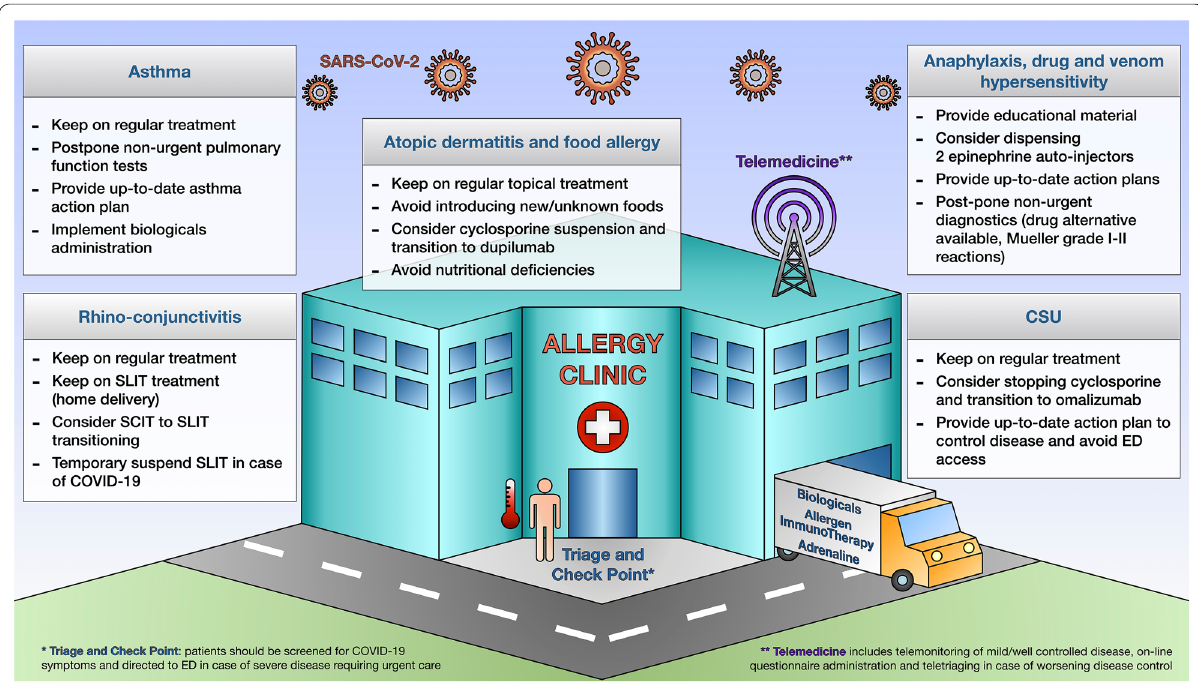
Fig. 2 An integrated model of tele- and digital-allergy clinic during COVID-19 pandemic. Suggested actions to be implemented in order to re-organize an allergy clinic are reported in boxes for asthma, rhino-conjunctivitis, atopic dermatitis and food allergy, anaphylaxis, drug and venom hypersensitivity and CSU. The truck represents the home-delivery service that should be activated for biologicals, AIT and self-injectable adrenaline